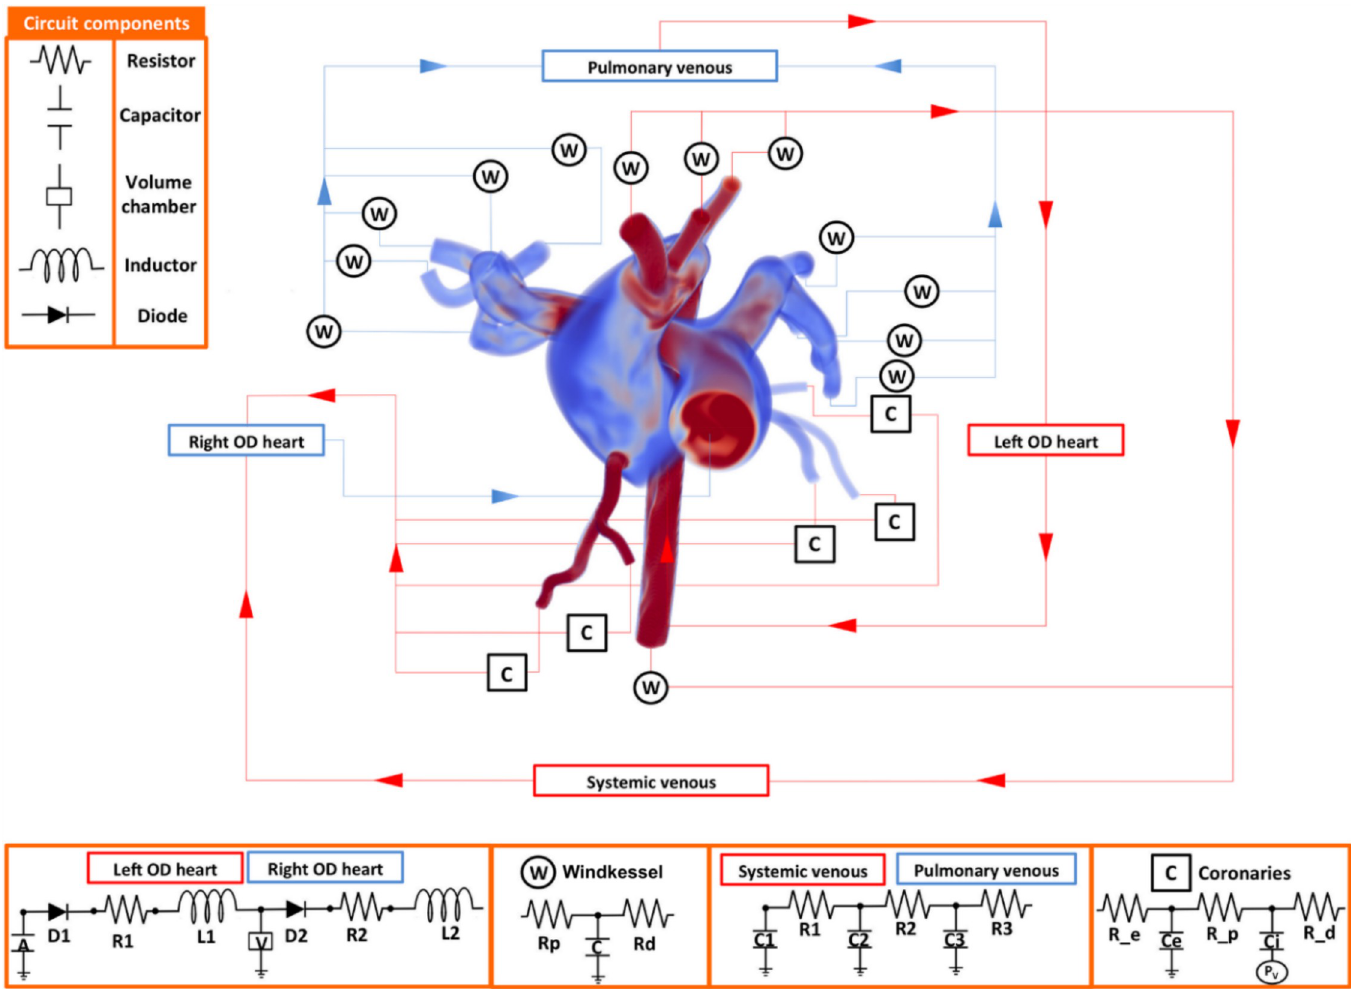
Fig 5. A complex, two-domain patient-specific 3D model with full closed-loop boundary condition system created in CRIMSON. This was used in a study of cardiovascular complications during liver transplant [44]. Image used under CC BY 4.0